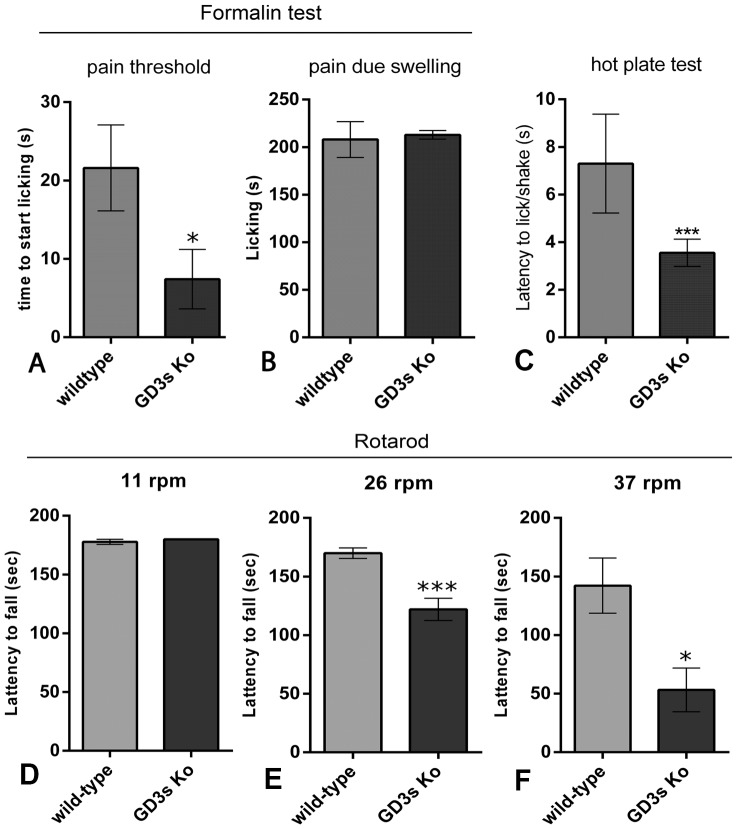
Sensory and motor behaviors of mice lacking GD3s.A–B: Histograms indicating the time to initiate licking (A) and licking duration (B) after injection of 5 µL of 2% formalin into the right forepaw (n = 10 for each group). C: Histogram indicating the latency of mice to initiate licking on a hot plate apparatus at 52°C (N = 10 for each group). D–F: Histograms indicating the motor behavior performed on the rotarod apparatus, on which mice were challenged daily at 11 rpm (C), 26 rpm (D) and 37 rpm (E). Statistics: Mann-Whitney * p<0.01; *** p<0.0001.